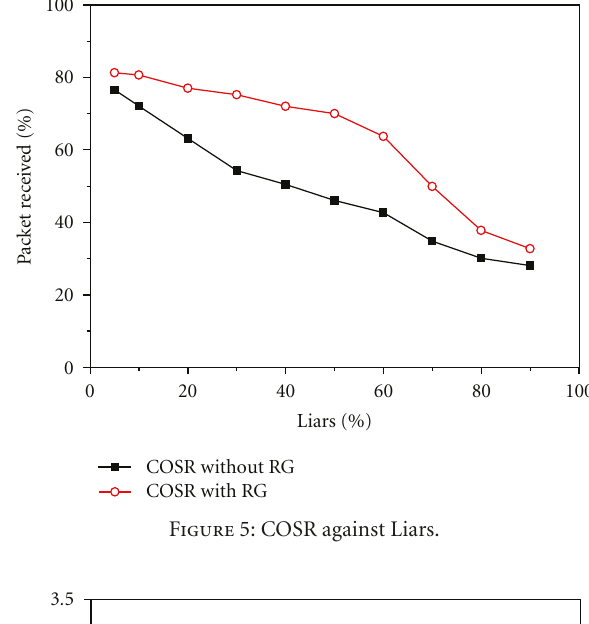
Figure 7: NPL of COSR and DSR with various maximum velocity.